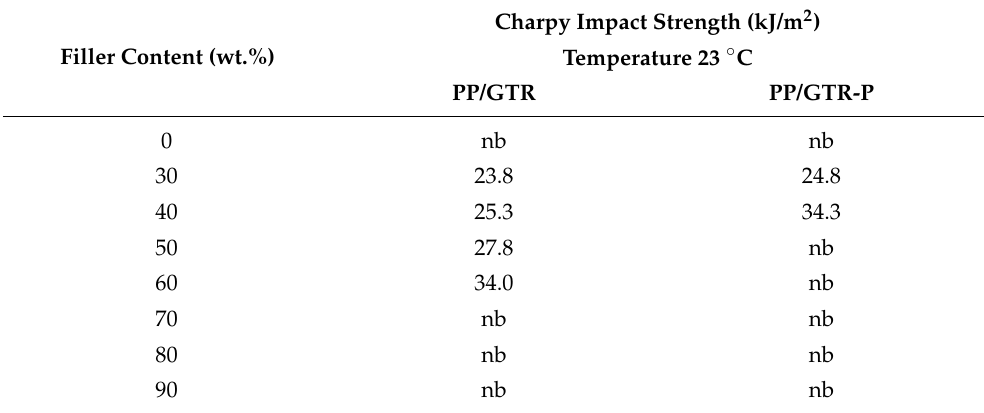
Table 5. Influence of GTR content on Charpy impact strength of PP/GTR compounds.